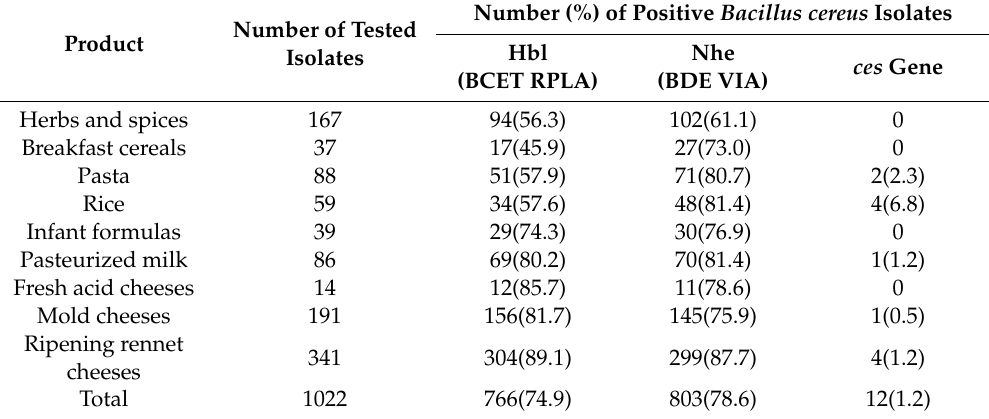
Table 3. The toxicity of Bacillus cereus